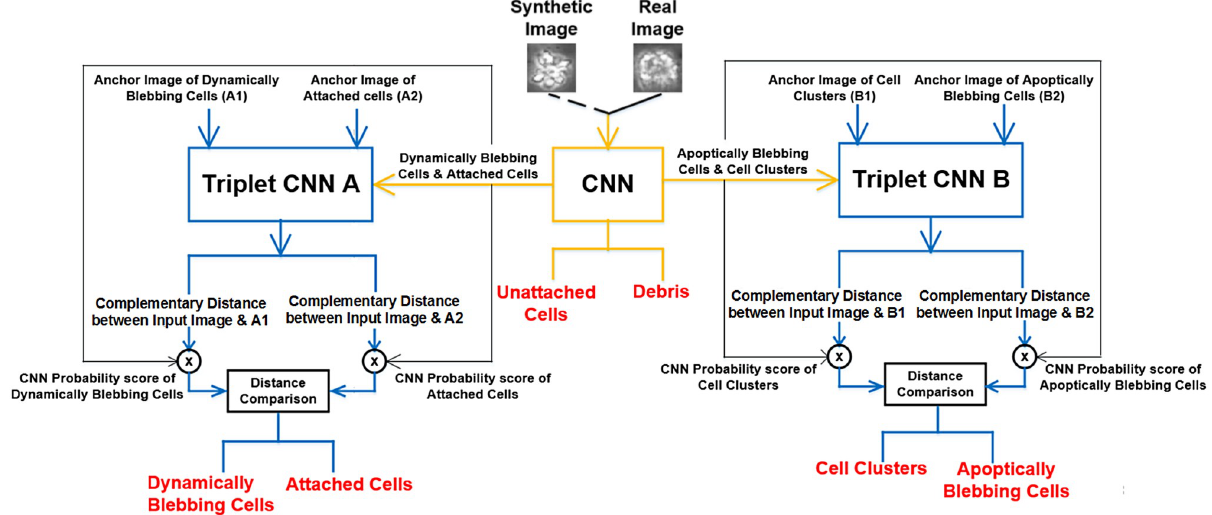
Fig 8. Workflow of the hierarchical classifier. The input is either a real or synthetic image belonging to one of the six classes. The outputs of the CNN and Triplet CNNs are fused at the decision level using the product rule.